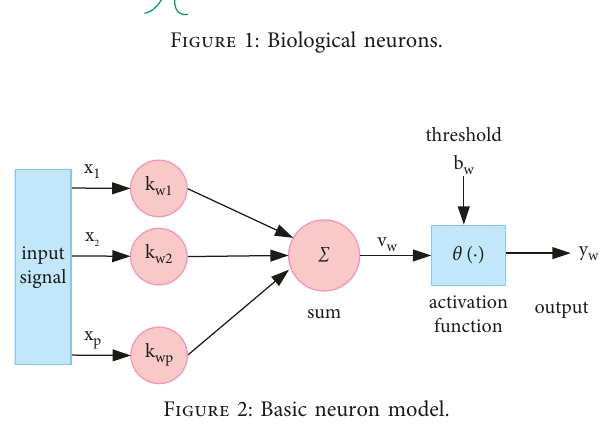
Figure 2: Basic neuron model.